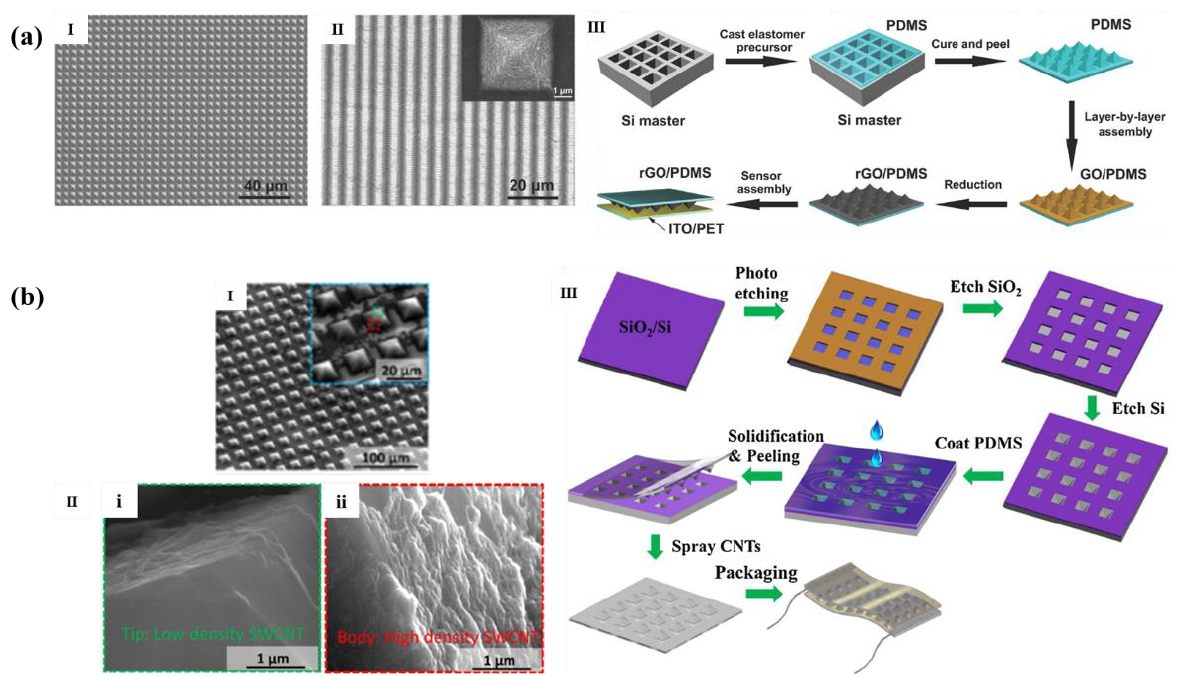
Figure 6. ( a , I ) SEM image of PDMS with uniform pyramid pattern array; ( II ) inclined SEM image of the microstructural PDMS film covered with graphene; ( III ) schematic diagram of tactile sensor manufacturing process [45]. ( b , I ) 45° SEM view of PDMS with uniform pyramid array; ( II ) SEM image of pyramid with ( i ) low-density SWCNT layer and ( ii ) high-density SWCNT layer; ( III ) manufacturing process of flexible pressure sensor [46].